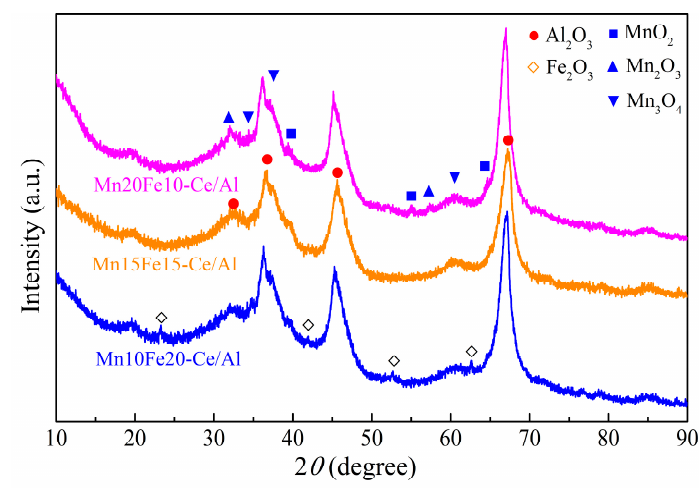
Figure 2. X ‐ ray diffraction (XRD) patterns of Mn − Fe − Ce − O x / γ‐ Al 2 O 3 nanocatalysts.